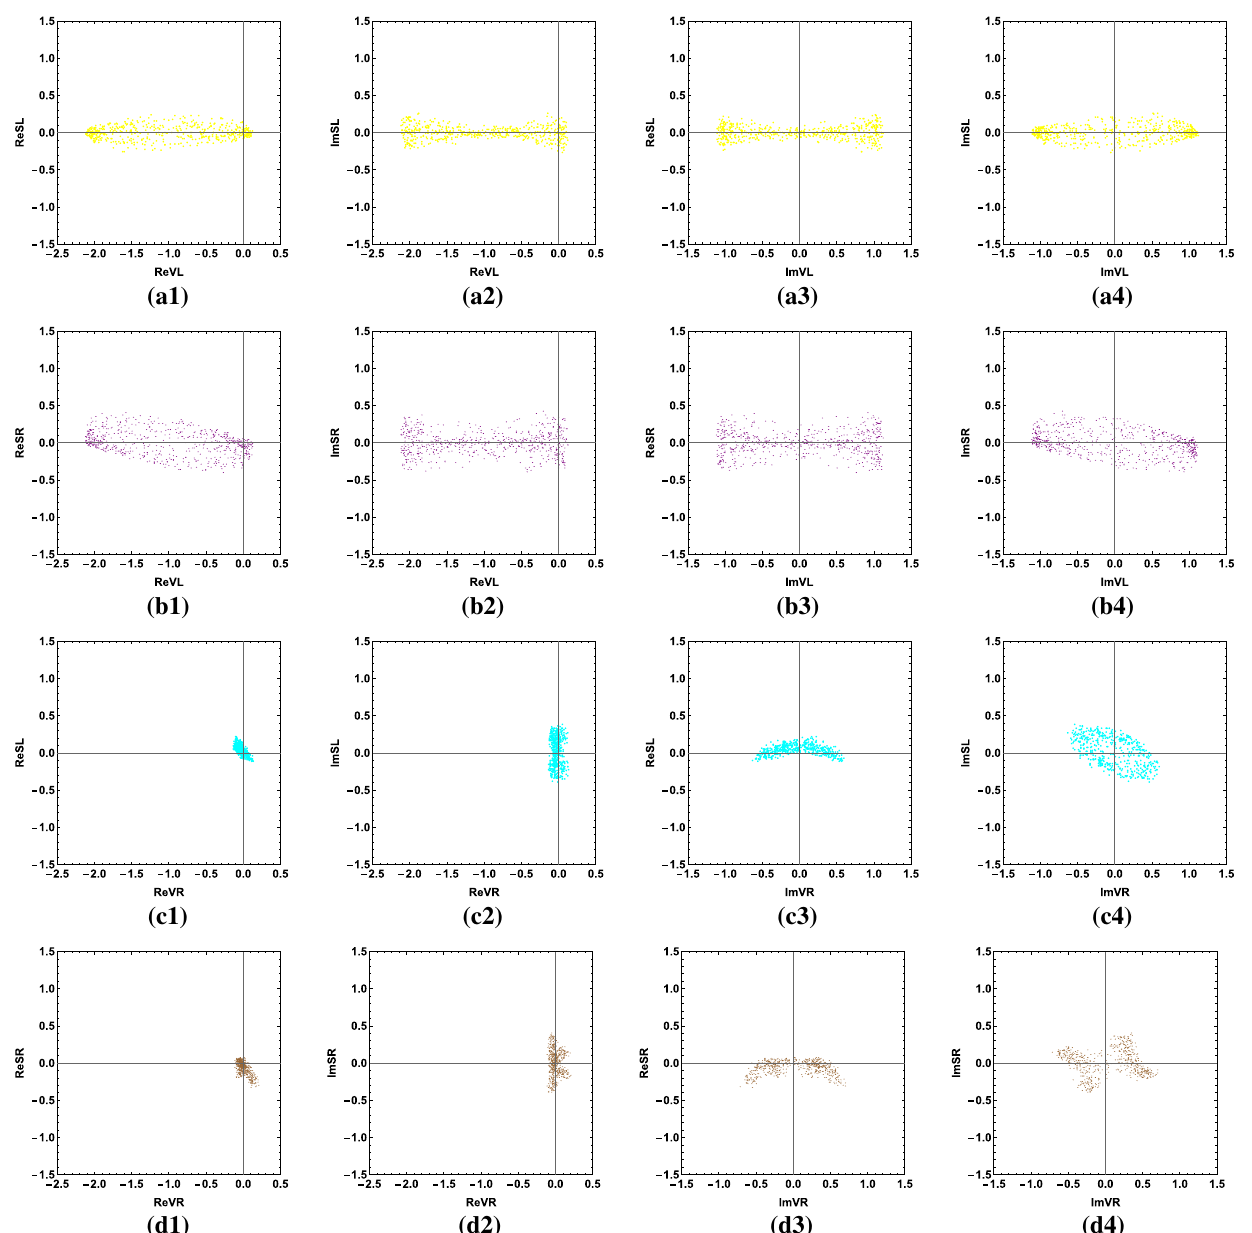
Fig. 2 The constraints on both real and imaginary parts of the NP Wilson coefficients V L and S L ( a1 – a4 ), V L and S R ( b1 – b4 ), V R and S L ( c1 – c4 ) and V R and S R ( d1 – d4 ) coming from Br ( B + c → τ + ν τ ) , R l π , R D ( ∗ ) , R J /ψ and F D ∗